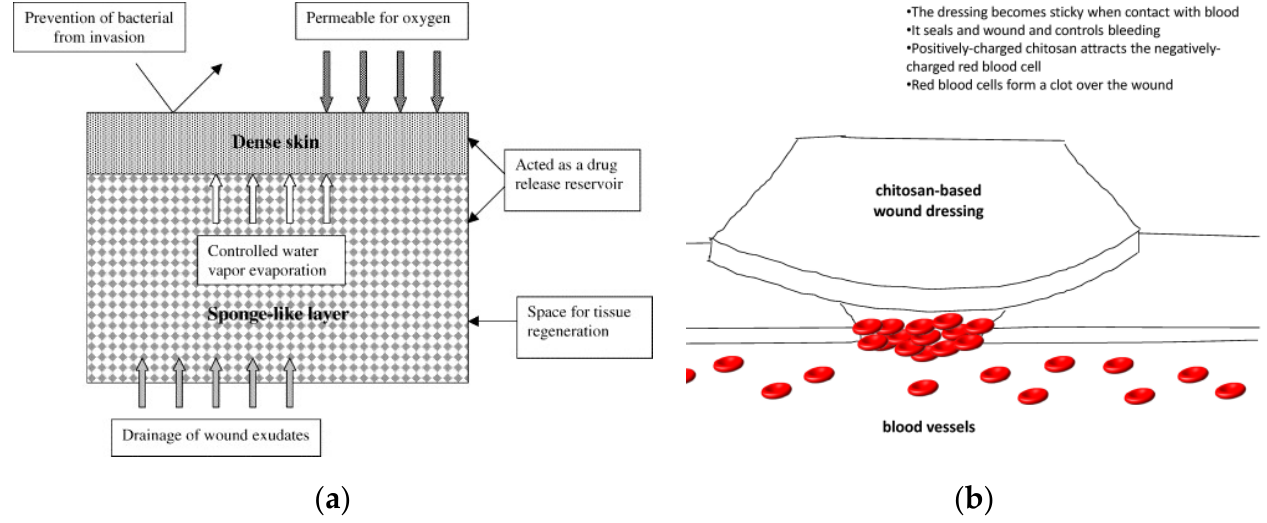
Figure 5. Sketch of ( a ) a flat chitosan-based asymmetric membrane for application in wound dressing. Reprinted from [51] with permission from Elsevier. ( b ) how the wound dressing works. Reprinted from [75] under open access CC-BY